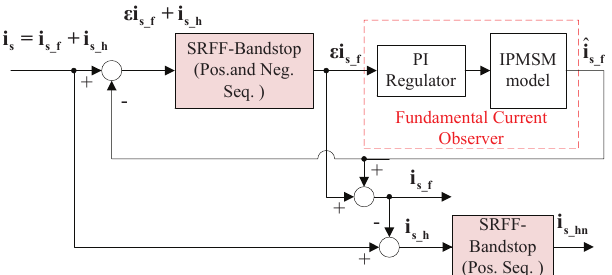
Figure 6. Simplified diagram of current-observer-based current filter used to separate the fundamen- tal and negative-sequence